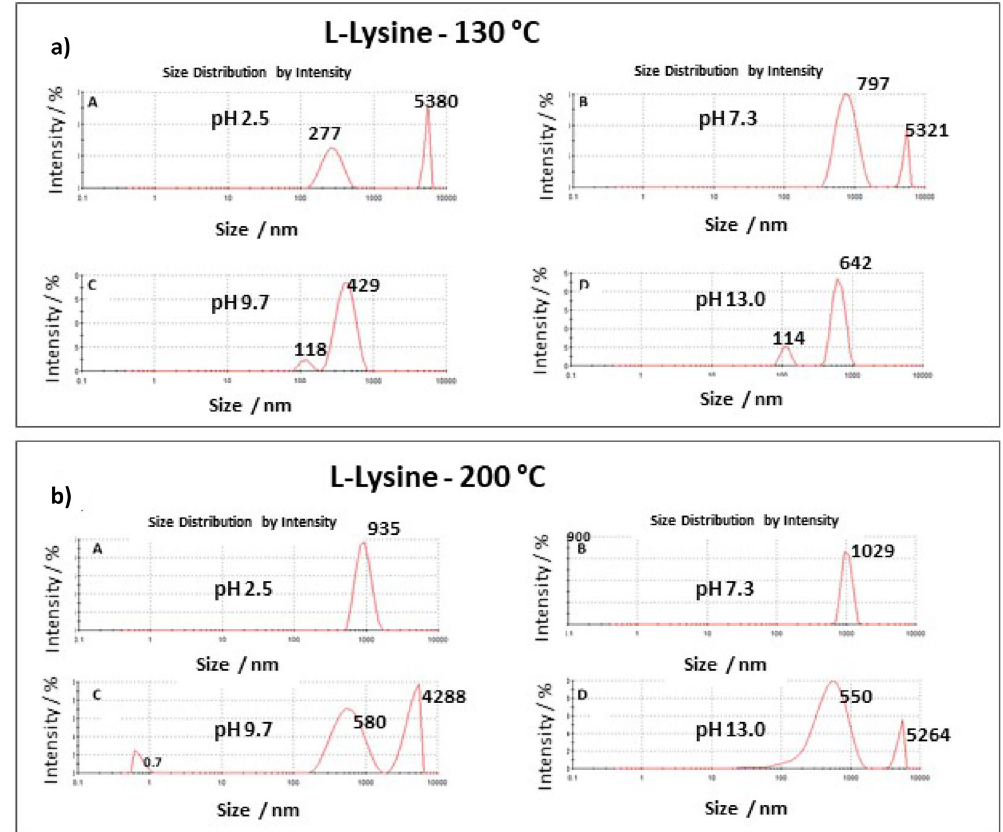
Figure 11. Size distribution by intensity of Dynamic Light Scattering of HTT-130 °C PLL ( a ) and HTT-200 °C ( b ) using as precursors the l-lysine aqueous solutions at pH 2.5, 7.3, 9.7 and